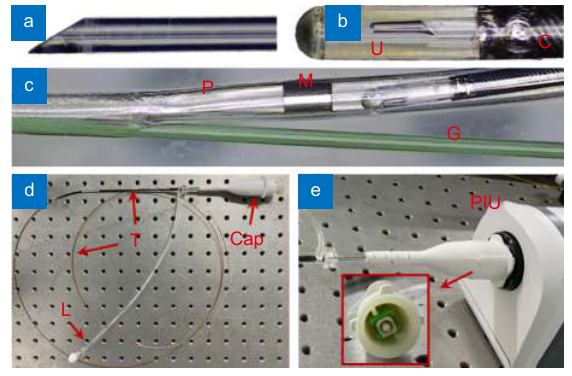
Fig. 4 | ( a ) Angle-polished probe. ( b ) Distal optics with coil. ( c ) Distal image of assembled catheter with a guide wire and ra- diopaque marker. ( d ) Full view of the whole catheter. ( e ) Connec- tion of the catheter and PIU. Inset: cap used to house the SC/APC connector. U: UV adhesive; C: double-wrapped torque coil; P: plastic sheath; M: radiopaque marker; G: 0.014-inch guide wire; T: catheter; L: Luer